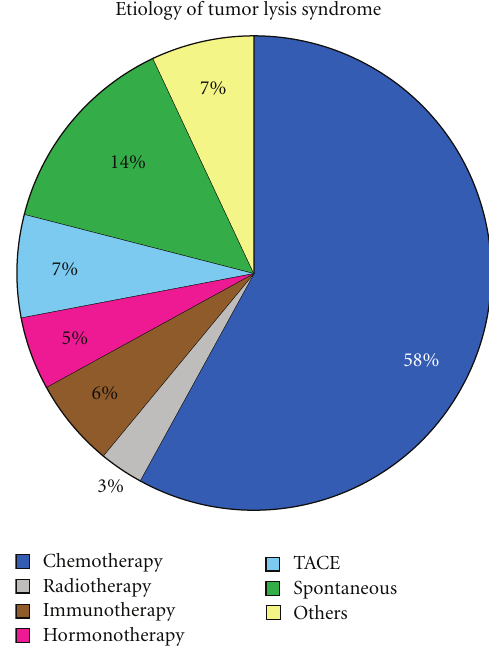
Figure 1: Etiology of tumor lysis syndrome. TACE: transarte- rial chemoembolization. Others include surgery, bisphosphonates, radiofrequency, combination of di ff erent cancer